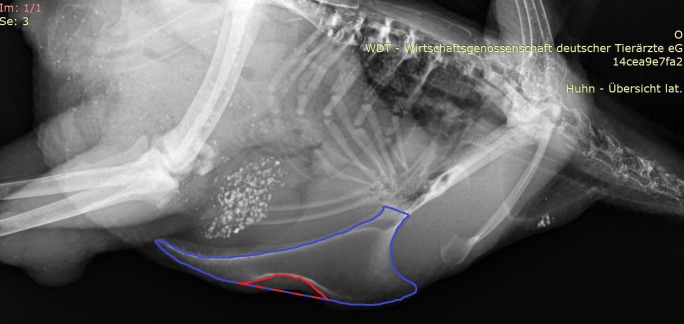
A deviated keel bone.The keel bone surface area is circumscribed with blue color; the area of deviation is circumscribed with red color. The blue-red line marks the straight line between the start and end point of thedeviated outline.